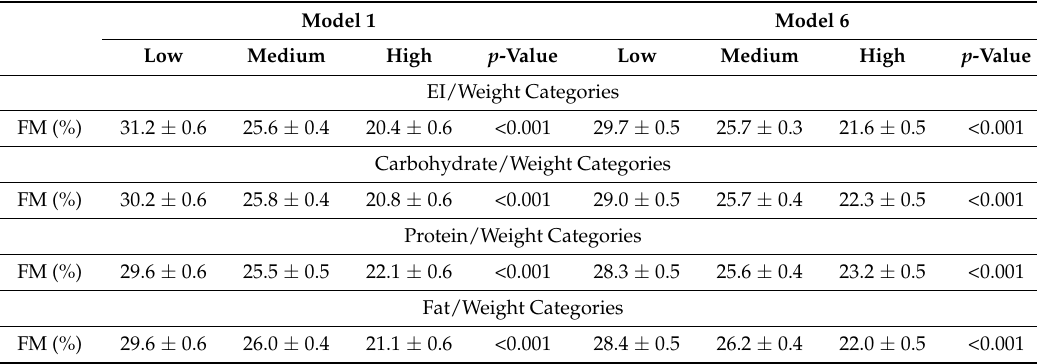
Table 4. ANCOVA models comparing mean differences in fat mass percentage by categories of dietary factors in